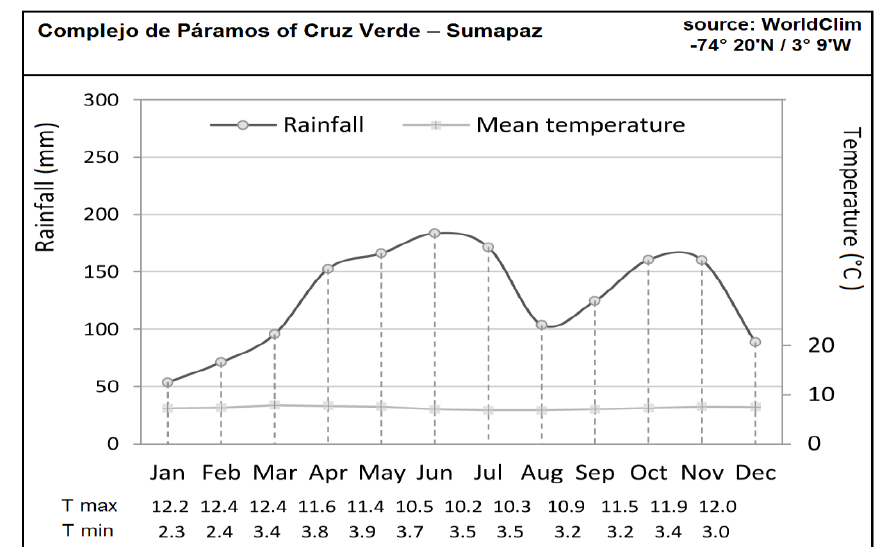
Figure 2. Annual distribution of temperature and precipitation at the study site (based